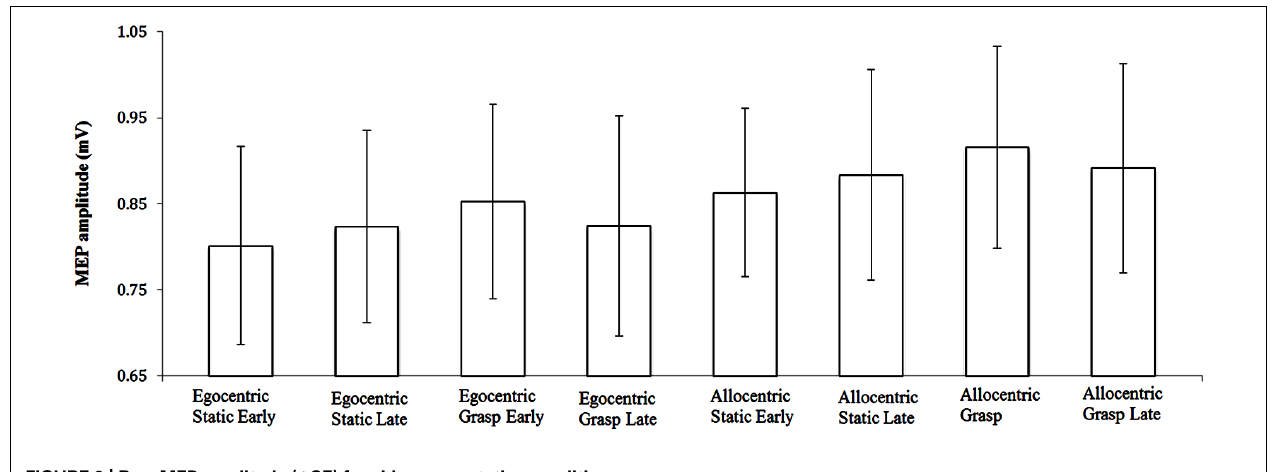
FIGURE 3 | Raw MEP amplitude ( ± SE) for video presentation